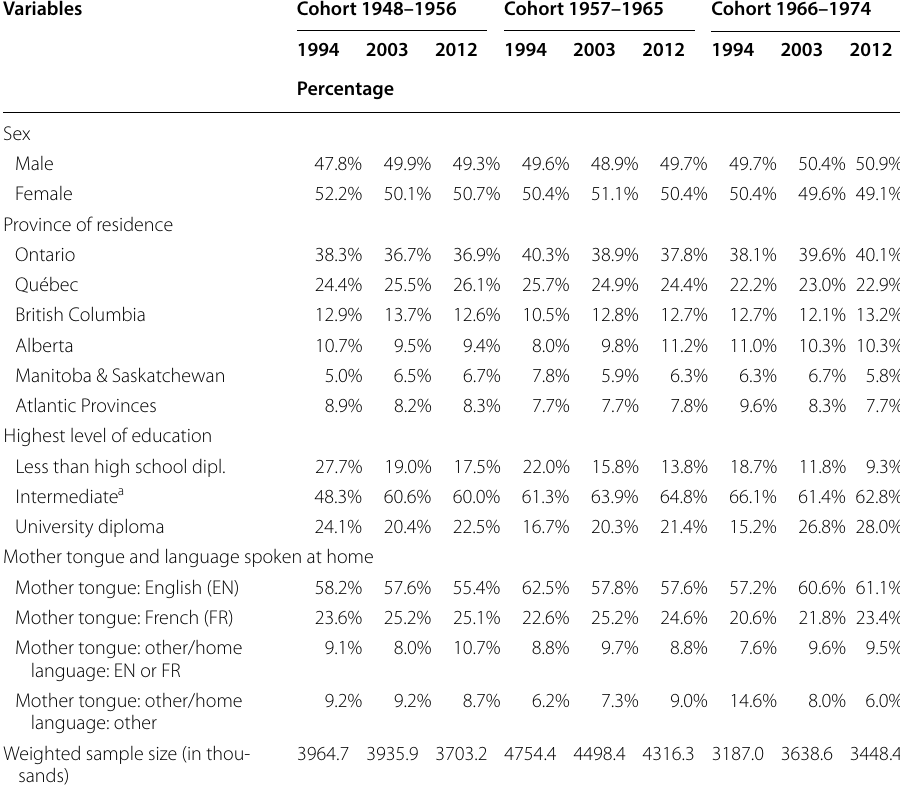
a High school diploma or post-secondary non-university diploma